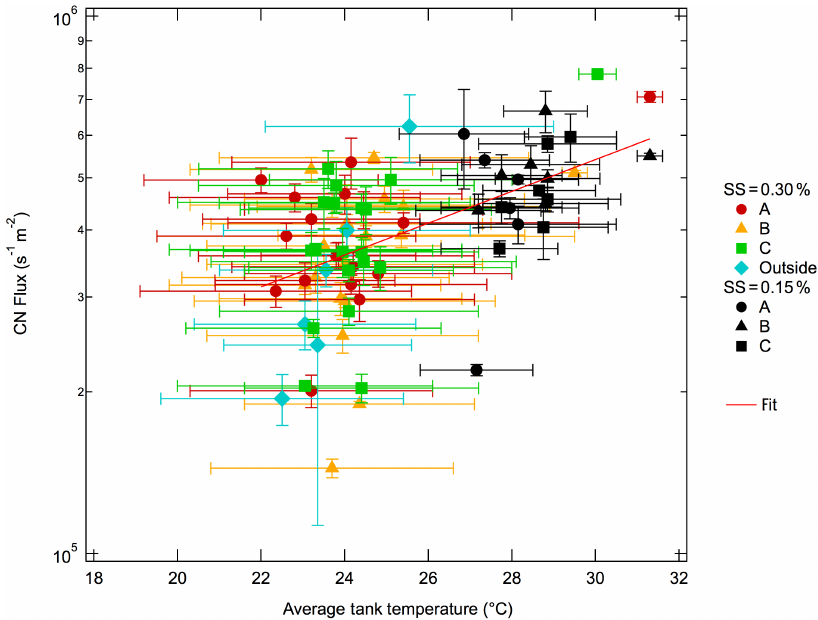
Figure 4. Particle flux calculated for a 9ms − 1 wind speed versus average tank temperature for both supersaturations tested.